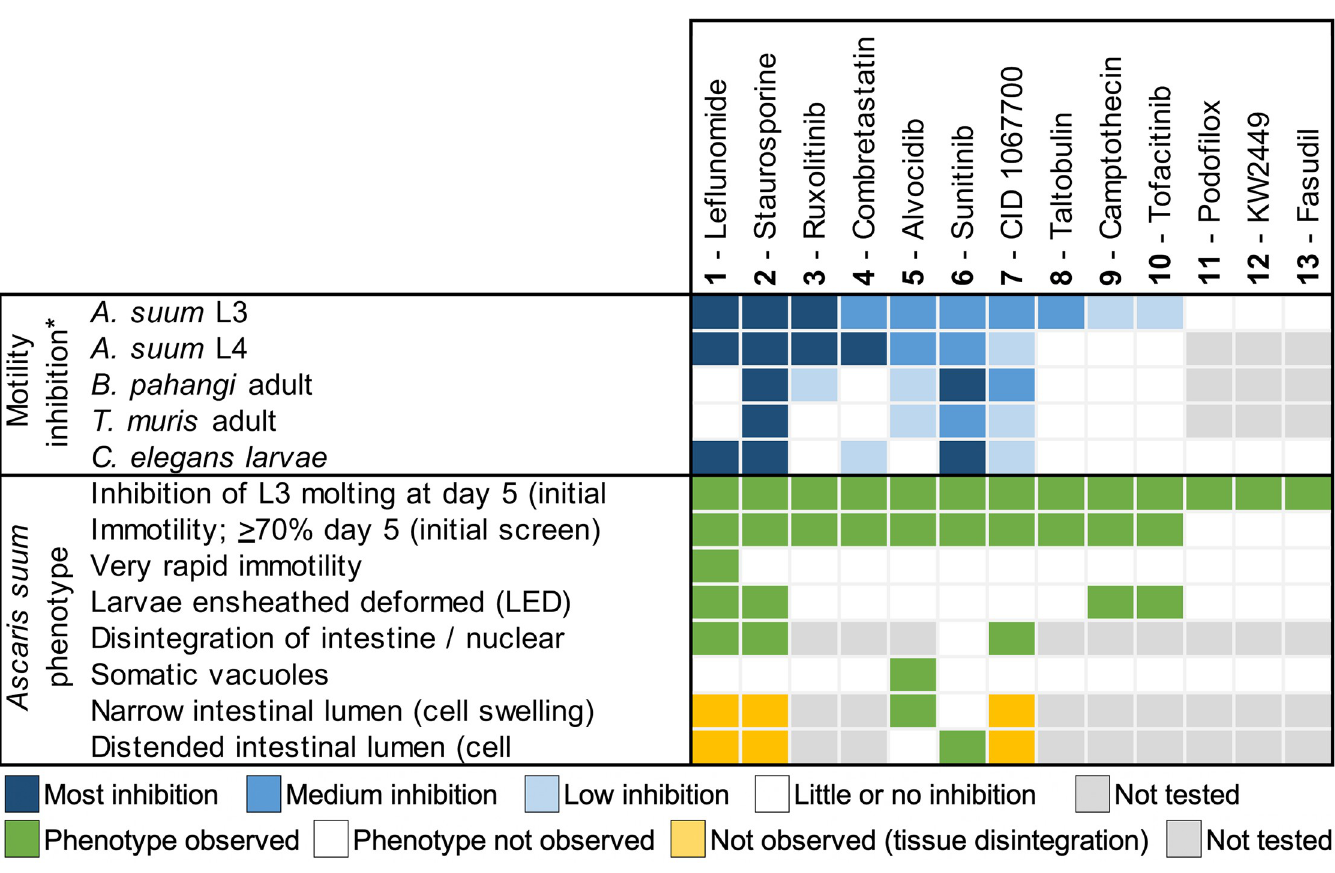
Fig 2. Summary of motility inhibition and observed phenotypes for the 13 tested Inhibitors in four species.